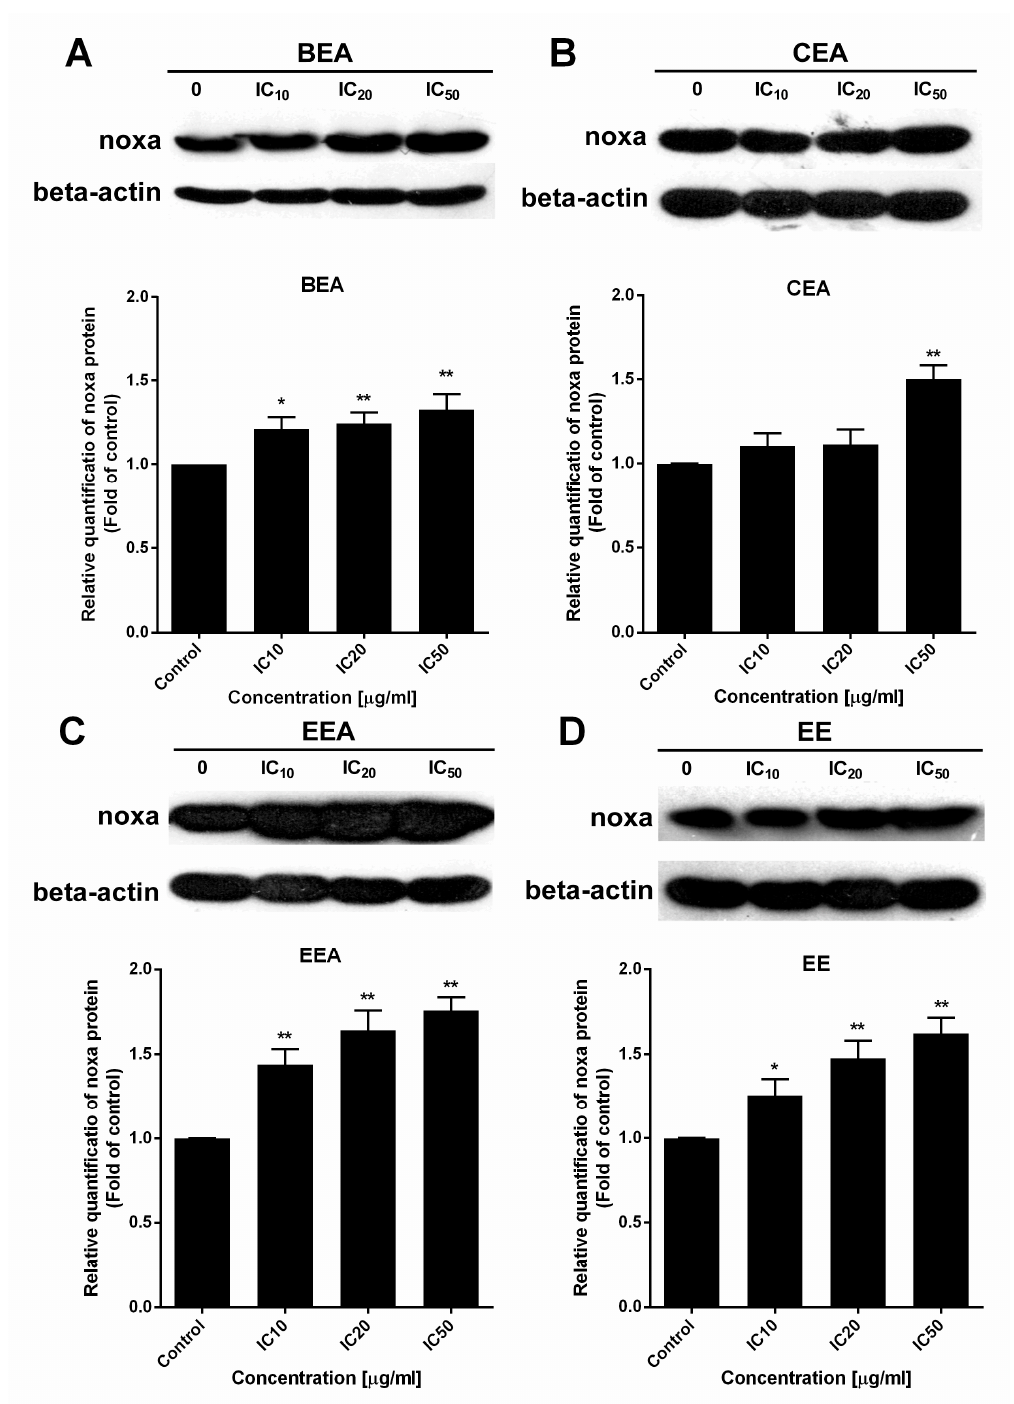
Figure 10. The effect of the effective extracts on Noxa protein expression level. Representations of Noxa protein bands after A549 cells were treated with ( A ) BEA, ( B ) CEA, ( C ) EEA, and ( D ) EE at indicated concentrations as shown in different lanes. The density of each band was measured and calculated for the relative protein level using beta-actin as an internal control (bar graphs). * p < 0.05, ** p < 0.01, treatment group vs. control un-treatment groups.